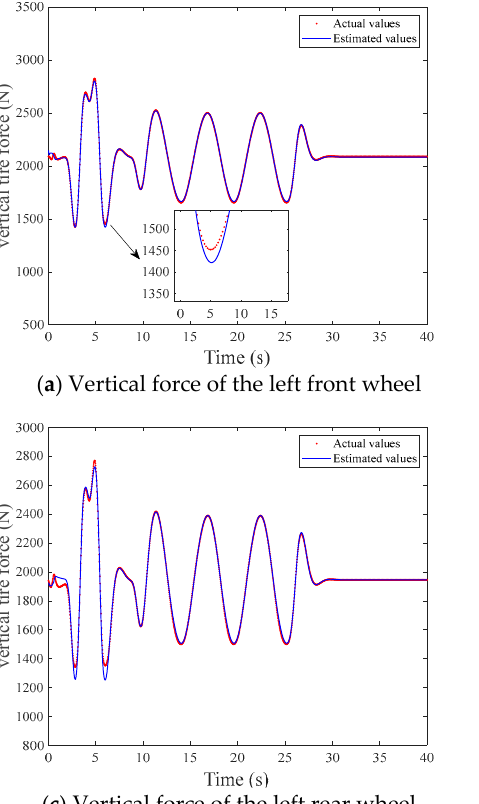
( c ) Vertical force of the left rear wheel ( d ) Vertical force of the right rear wheel